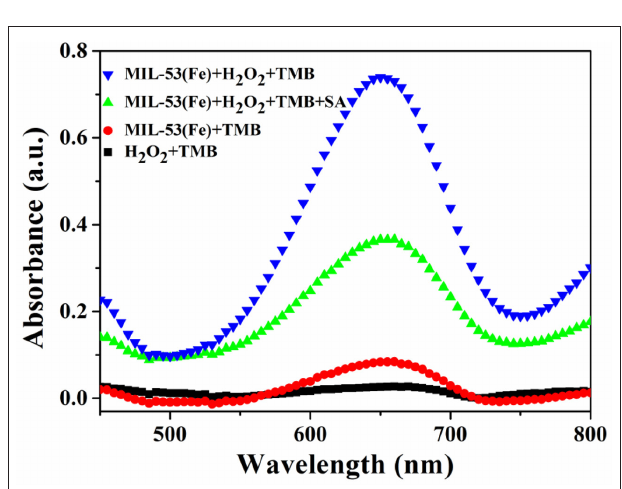
FIGURE 4 | UV-Vis absorbance spectra on the feasibility analysis for the detection of SA based on the MIL-53(Fe) nanozyme.